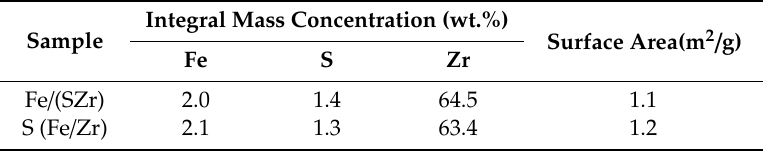
Table 1. Brunauer-Emmett-Teller (BET) surface area and integral mass concentration of various catalysts by Inductive Coupled Plasma (ICP)